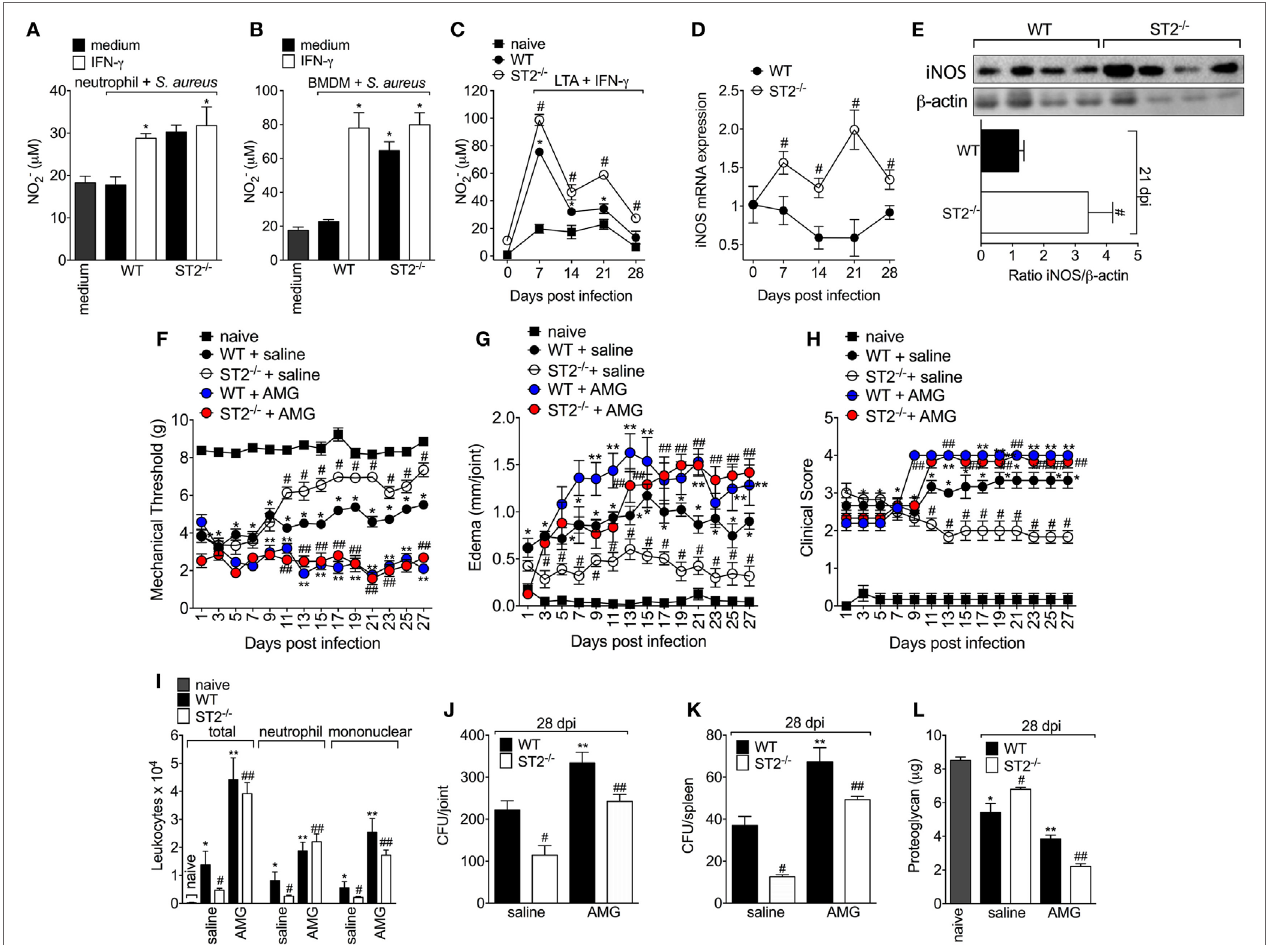
FigUre 4 | ST2 deficiency enhances NO production by neutrophils and macrophages and reduces Staphylococcus aureus -induced septic arthritis. NO production was determined as nitrite concentration by Griess reagent in the culture supernatant of (a) neutrophils and (B) bone marrow-derived macrophages (BMDMs) cells from wild-type (WT) or ST2 − / − naïve mice preincubated in vitro with interferon- γ (IFN- γ ) (100 IU/ml, 1 h) or medium, followed by incubation with S. aureus , or (c) in the culture supernatant of macrophages like-cells isolated from peritoneal cavity of WT or ST2 − / − mice with staphylococcal arthritis and challenged with lipoteichoic acid (LTA) (10 µg/ml, a toll-like receptor 2 agonist) plus IFN- γ (100 UI/ml) for 48 h. S. aureus or saline (day 0) was injected in the femur-tibial joint of WT and ST2 − / − mice and knee joint samples were collected and processed to determine: (D) the mRNA and (e) protein expression of iNOS at indicated time points post-infection by qPCR and Western Blot, respectively. WT and ST2 − / − mice were treated with aminoguanidine (AMG, 30 mg/kg, s.c., 150 µl) or vehicle (saline, 150 µl) over 28 days after i.a. S. aureus [10 7 colony-forming unity (CFU)/10 μ l/joint] injection: (F) mechanical hyperalgesia, (g) articular edema, and (h) clinical severity score were evaluated